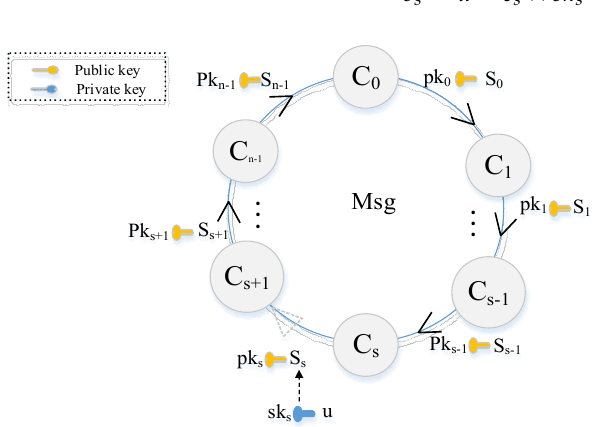
Figure 2. The structure of ring signature.